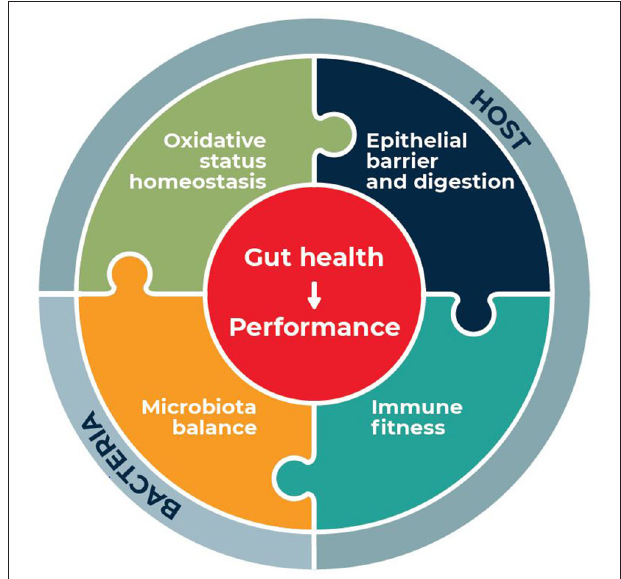
FIGURE 1 | definition of gut health for farm